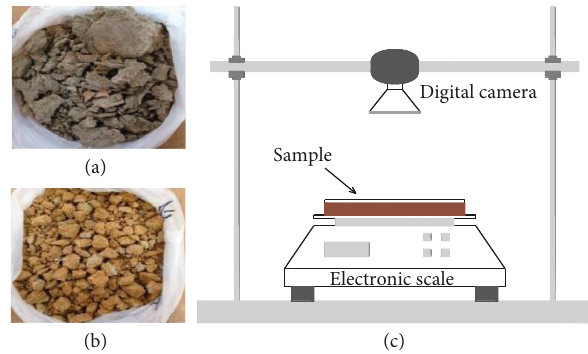
Figure 2: Using rocks and experimental set-up used for crack observation.